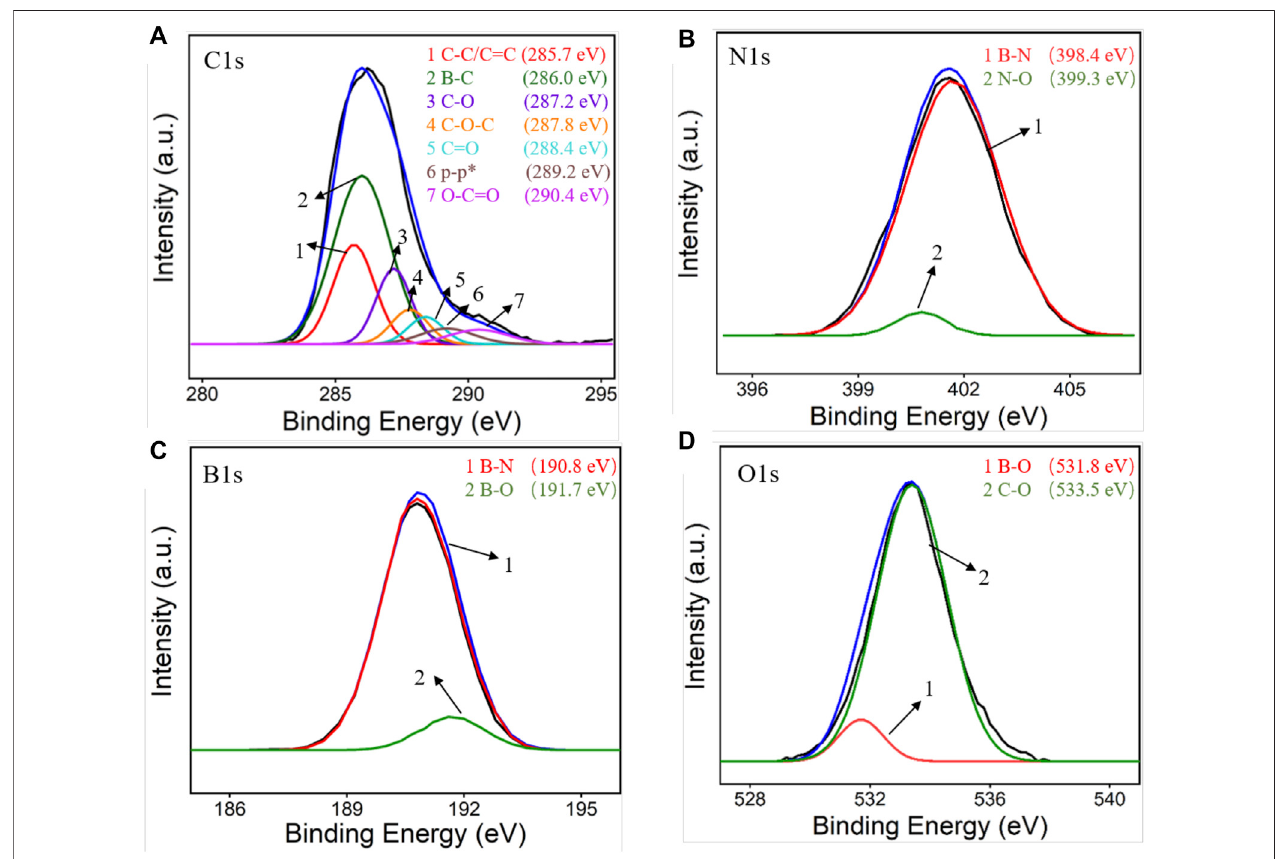
FIGURE 1 | High resolution XPS spectra of BN-rGO: (A) C1s, (B) N1s, (C) B1s, and (D) O1s.